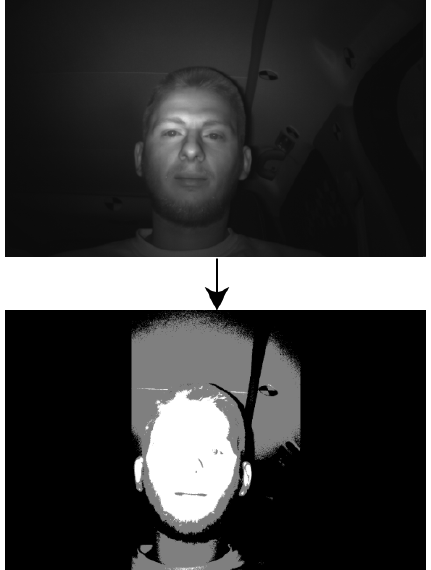
Figure 2. Example of input image converted from grayscale to